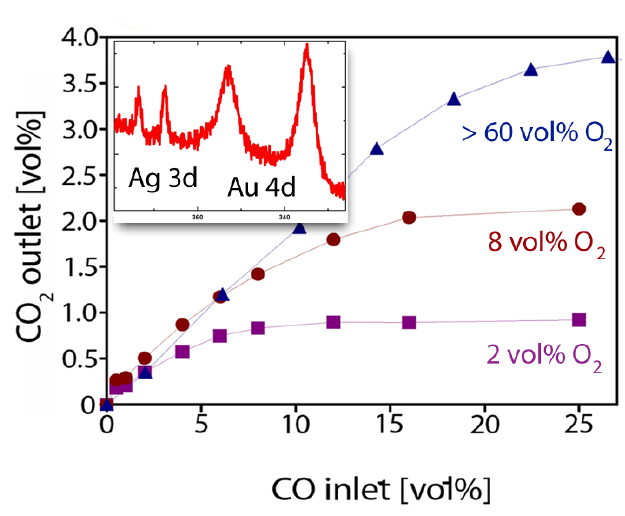
Figure 4. An example demonstrating the high catalytic activity of np-Au for CO oxidation concentration produced on the CO at 20 °C. Shown is the dependence of the CO 2 concentration supplied for different oxygen partial pressures. Total conversion is observed up to 2 vol % CO, at higher CO concentrations in the feed the conversion becomes limited by mass transport. The measurements were performed in a continuous flow reactor described in detail in ref. [38]. Inset: The amount of Ag present on the ligament surface of np-Au can be quantified by x-ray photoemission spectroscopy (shown are the Ag 3d and Au 4d